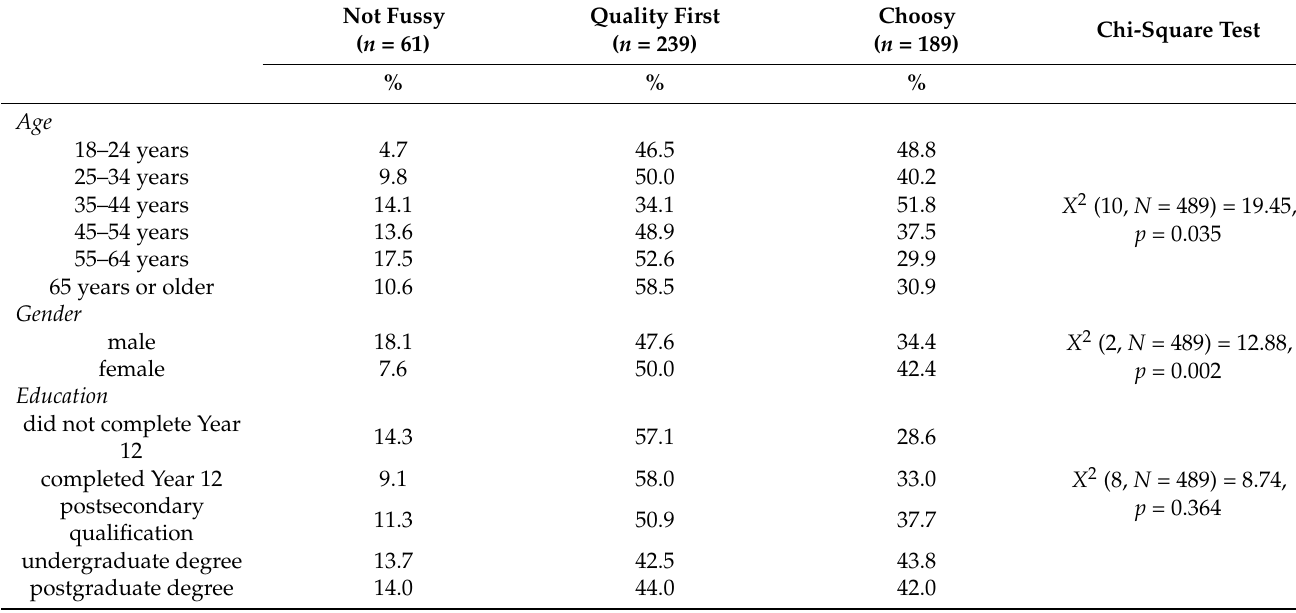
Table 3. Demographic characteristics, means and standard errors of food attributes for the three profiles. Not